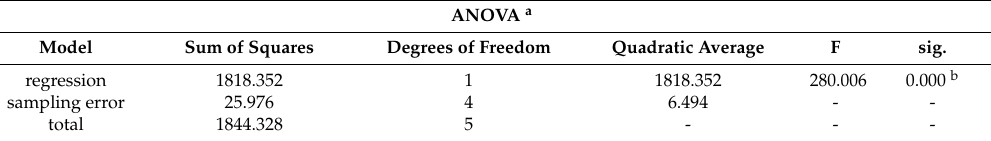
Table 12. Variance analysis for topographic settlement test and second modulus of PLT ( ɸ 600mm) at crown.